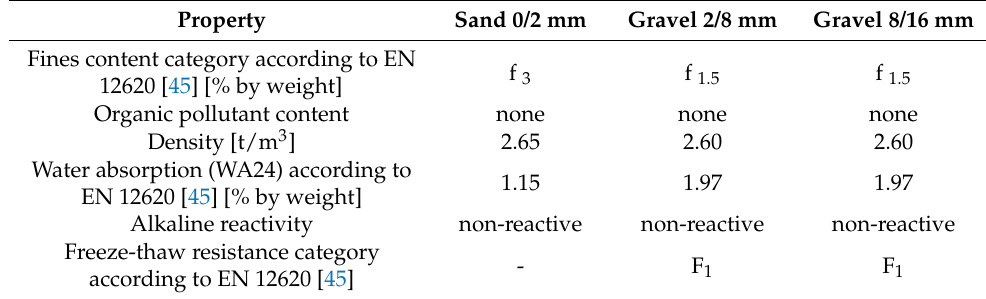
Table 4. Sand and gravel